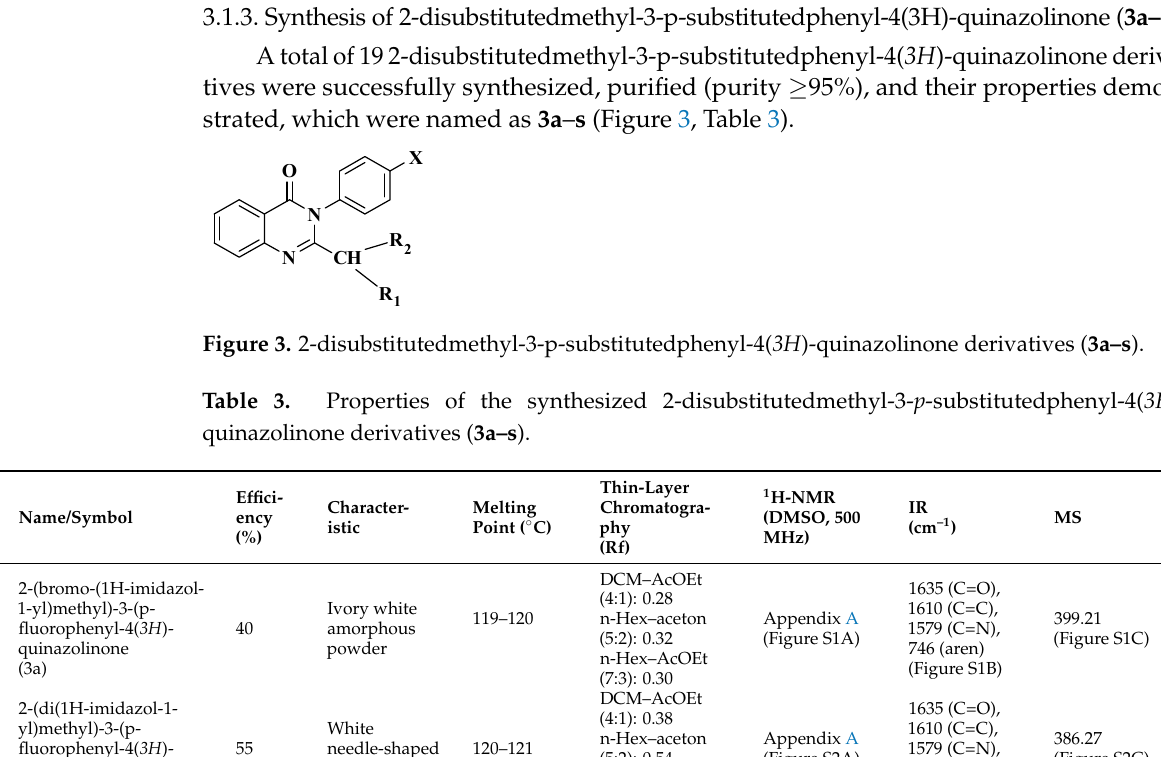
Figure 3. 2-disubstitutedmethyl-3-p-substitutedphenyl-4( 3H )-quinazolinone derivatives ( 3a–s ). Table 3. Properties of the synthesized 2-disubstitutedmethyl-3- p -substitutedphenyl-4( 3H )-quinazo- linone derivatives ( 3a–s ).